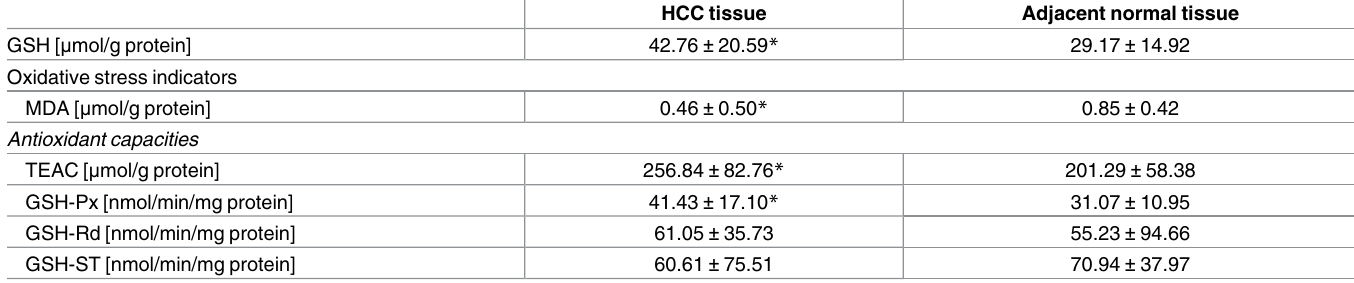
Table 3. Reduced glutathione, oxidative stressindicator, and antioxidant capacities in hepatocellular carcinoma tissues and adjacent normal